Question: What visual encoding does this figure use to show its data?
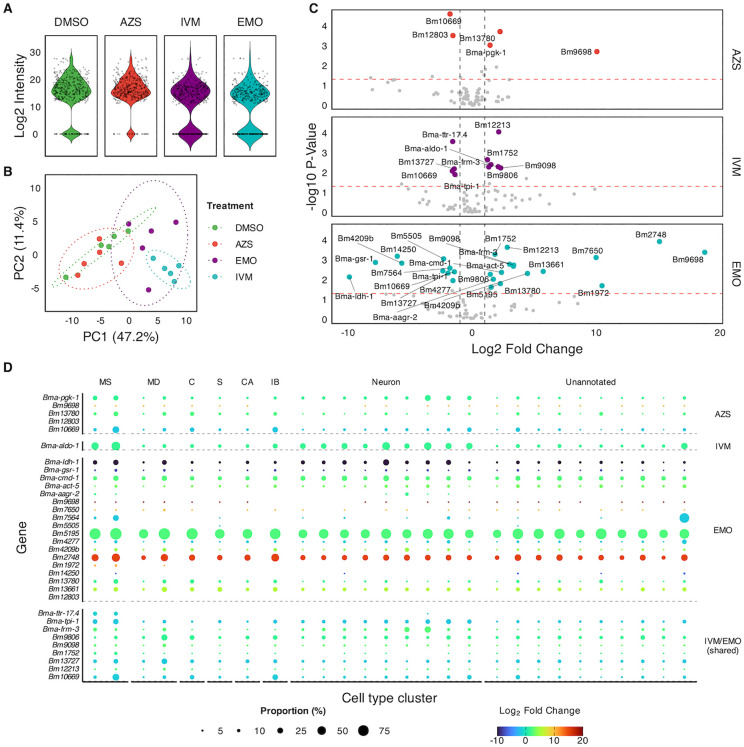
Answer: box